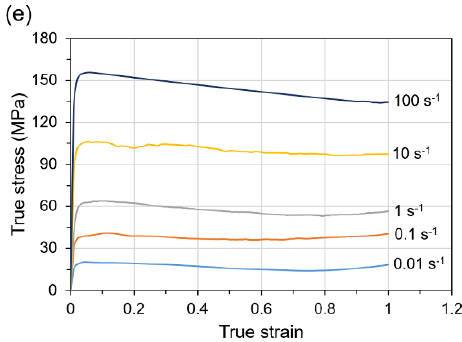
Figure 2. The true stress-true strain curves for Ti-1023 alloy deformed in compression at the temperature of ( a ) 800 °C, ( b ) 900 °C, ( c ) 950 °C, ( d ) 1000 °C, ( e ) 1100 °C and at various strain rates.